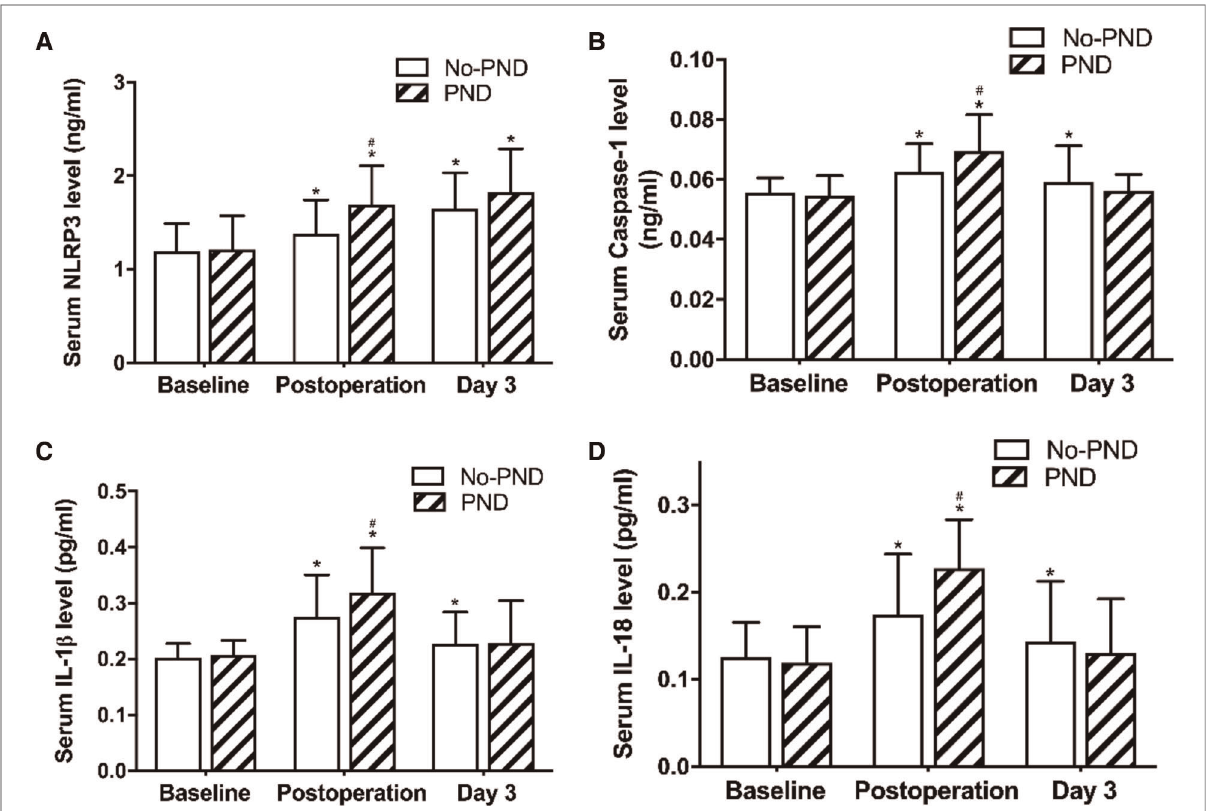
FIGURE 2 Serum NLRP3, caspase-3, IL-18, and IL-1 β in non-PND and PND groups. * P< 0.05 vs. baseline; # P< 0.05 vs. the non-PND group at same time-point. A moderate positive association between NLRP3 and IL-1 β ( r =0.330, P =0.004) levels and a weak positive association of increase in NLRP3 with increase in IL-18 ( r =0.265, P =0.021) and caspase-1 ( r =0.241, P =0.038) levels was observed at the end of the surgery ( Figure 3 ). Abbreviations: NLRP3, Nod-like receptor family pyrin domain containing 3; PND, Perioperative neurocognitive disorders; IL, interleukin.